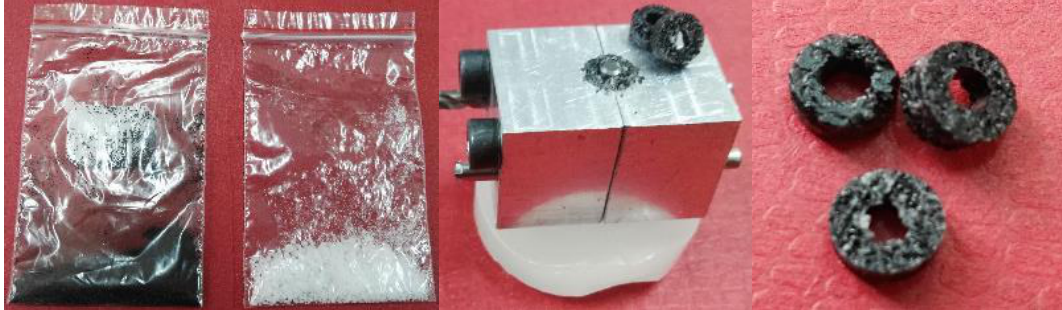
Figure 10. Preparation of coal and gangue samples for electrical parameters.